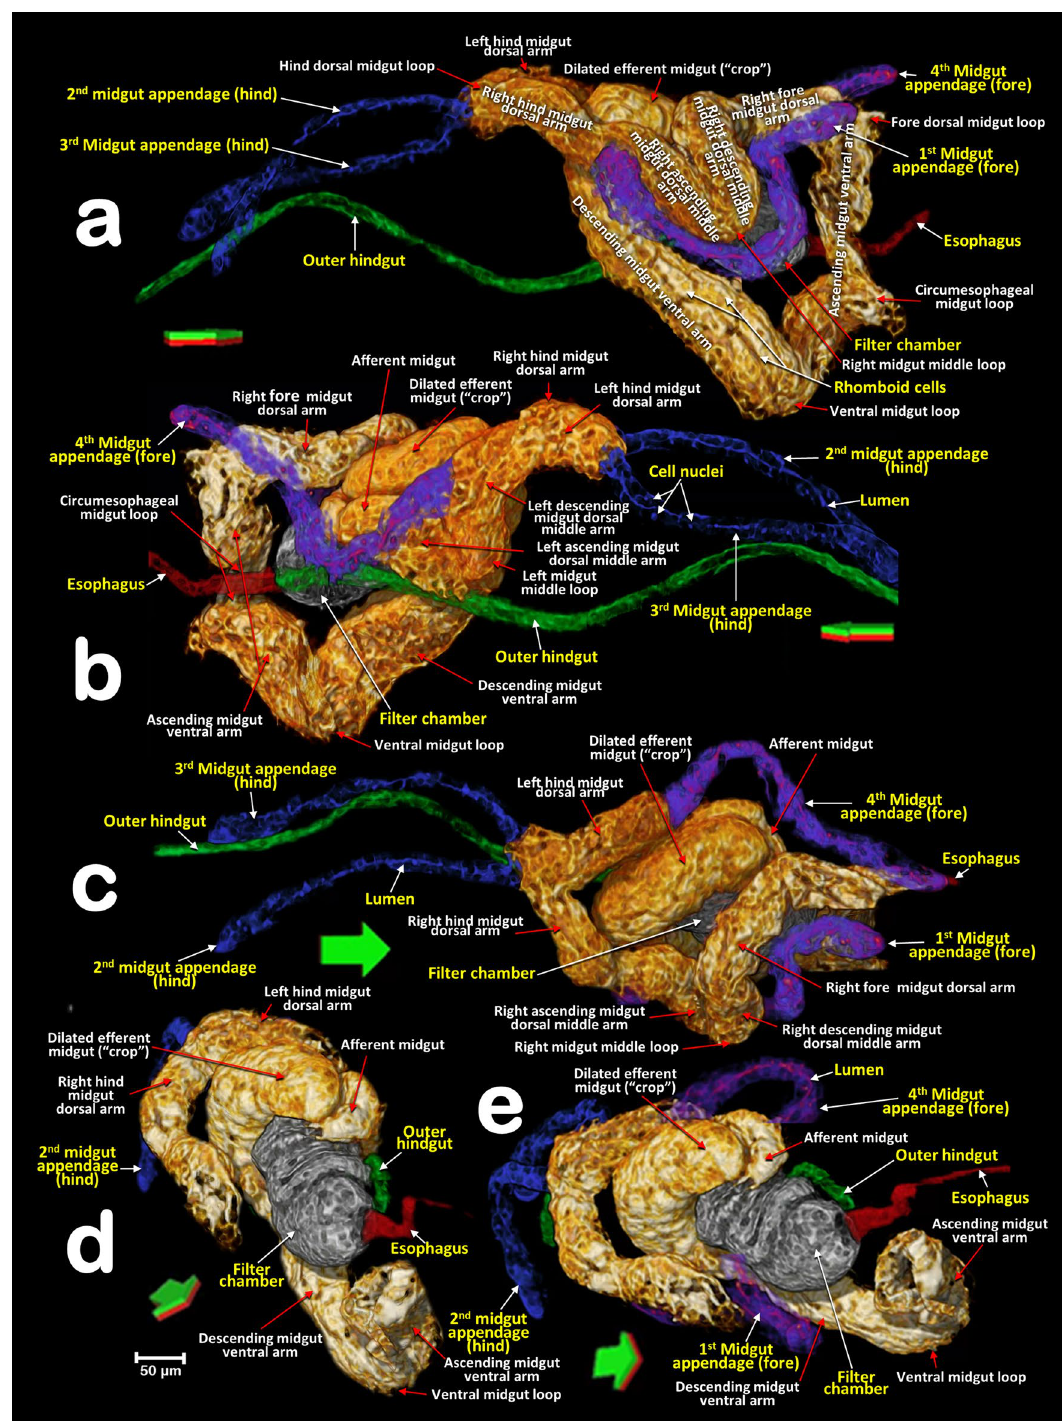
Figure 13. Volume-rendered close-up images of the digestive system of a male Diaphorina citri in different perspectives. Right-lateral ( a ), left-lateral ( b ), dorsal ( c ), right-frontal ( d ) and right-oblique-dorsal ( e ). Arrows indicate the anatomical positions. Green/red surfaces correspond with dorsal/ventral